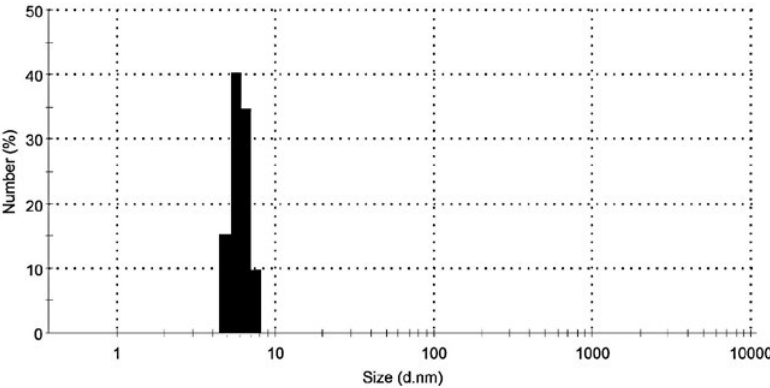
Fig. 5. Size distribution of prepared ZnS:Ag NPs obtained by DLS technique.